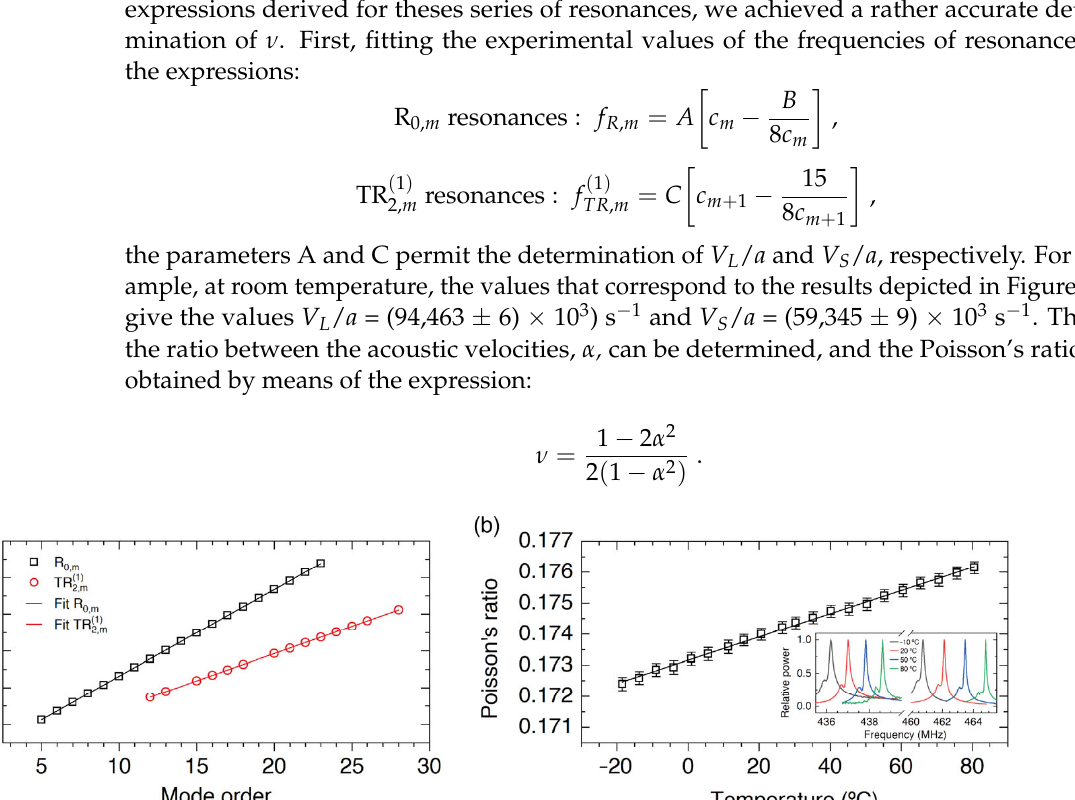
Figure 5. ( a ) Experimental frequencies for radial, R 0, m , and torsional-radial, TR sus the order m at 20 °C, and the corresponding fits. ( b ) Poisson’s ratio as a function of the temperature, and a linear fit. The inset shows the RF spectra for different temperatures corresponding to resonances R 0,10 and TR 2,15